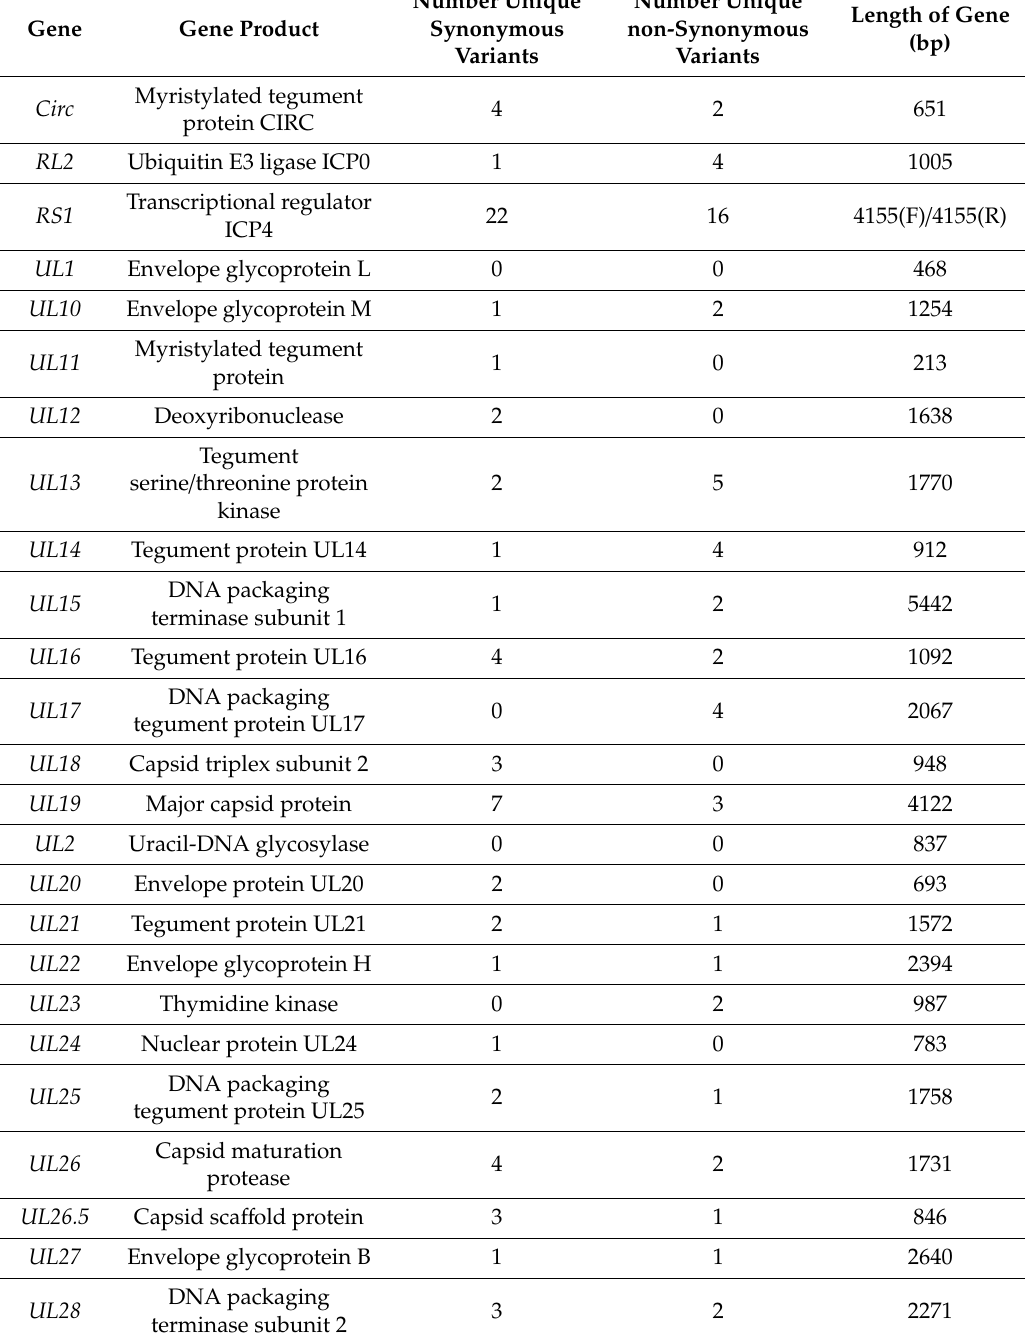
Table 3. Summary of variants detected, organized by gene involved. F = Forward, R =